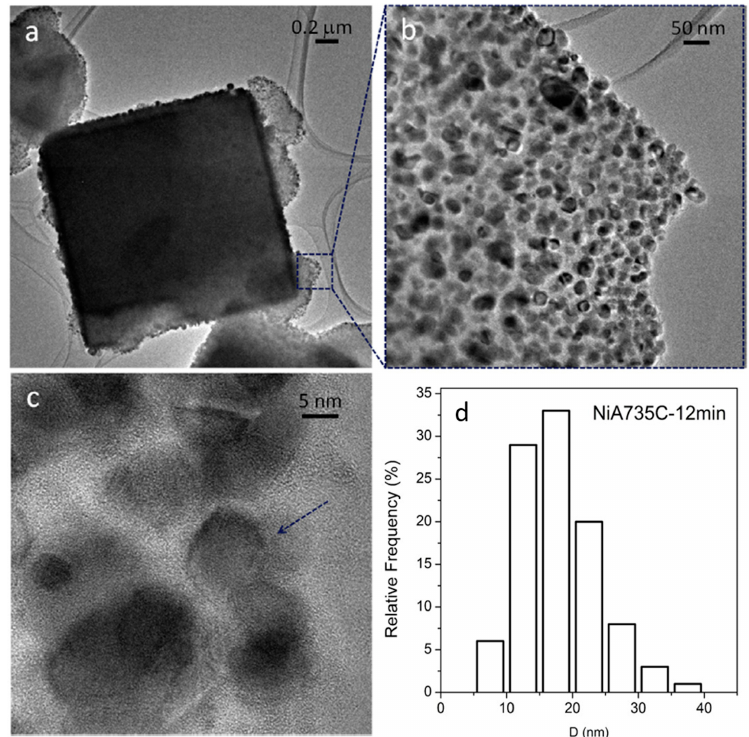
Figure 11. TEM ( a , b ) and HR-TEM (high resolution TEM) ( c ) images of the NiA735C—12 min sample. Instrumental magnification: 6000×, 30,000×, and 400,000×. Reprinted in modified form from the work of [14] with permission from Elsevier. ( d ) Ni particle size distribution. Appl. Sci. 2018 , 10 , x FOR PEER REVIEW